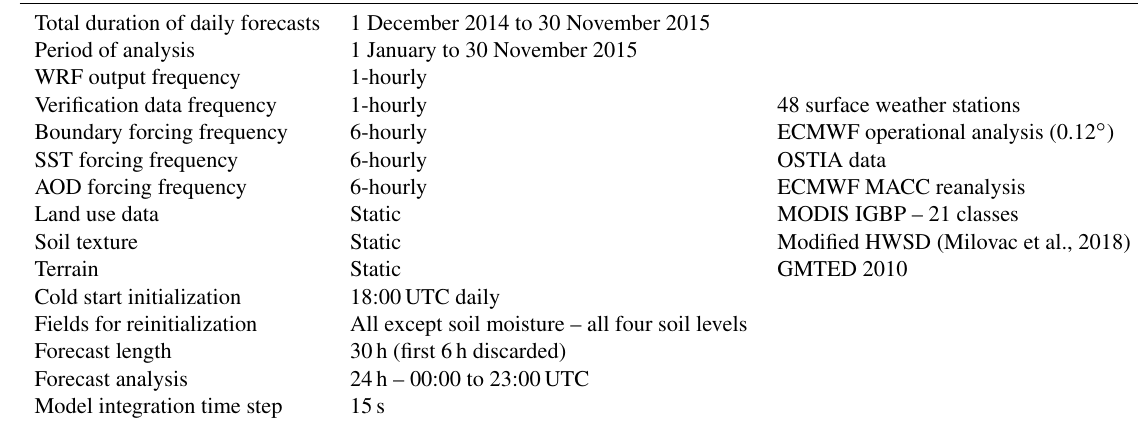
Table 2. Summary of main aspects of